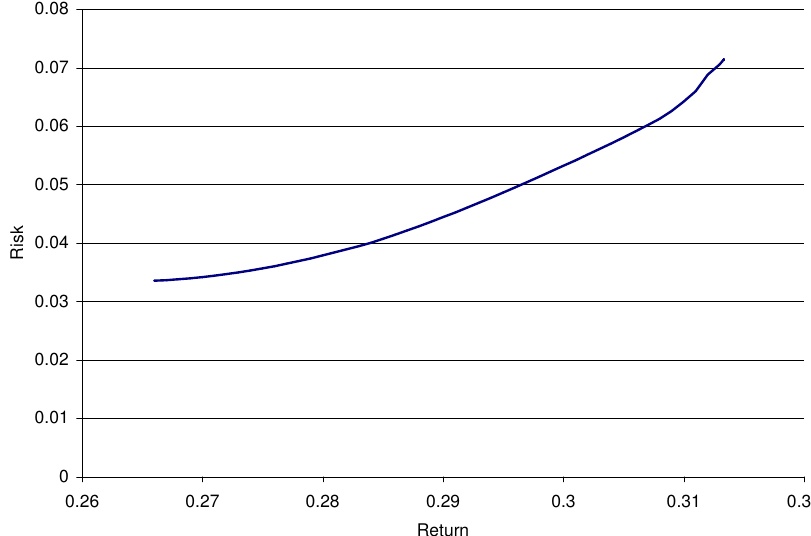
Figure 1: Efficient frontier of (risk, return) values as solution to